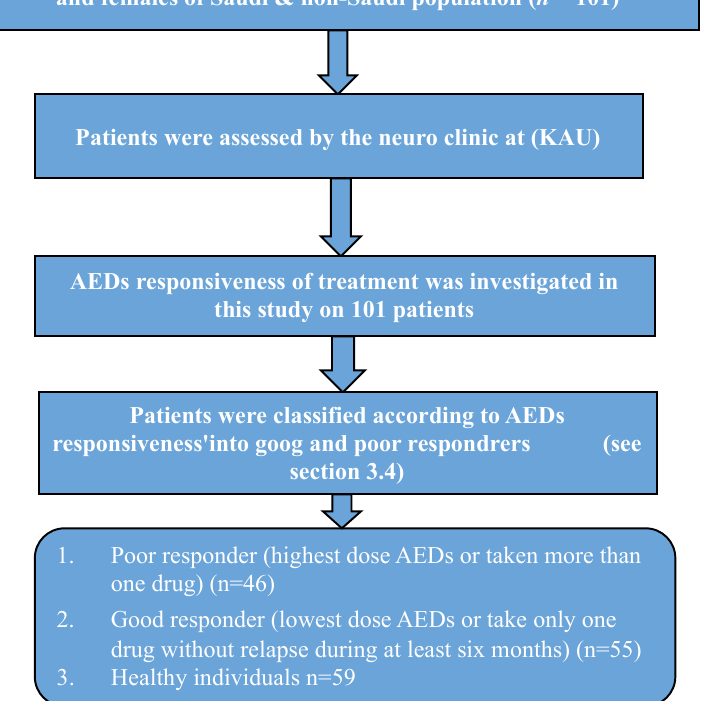
Figure 1. Flowchart of enrollment and analysis process.